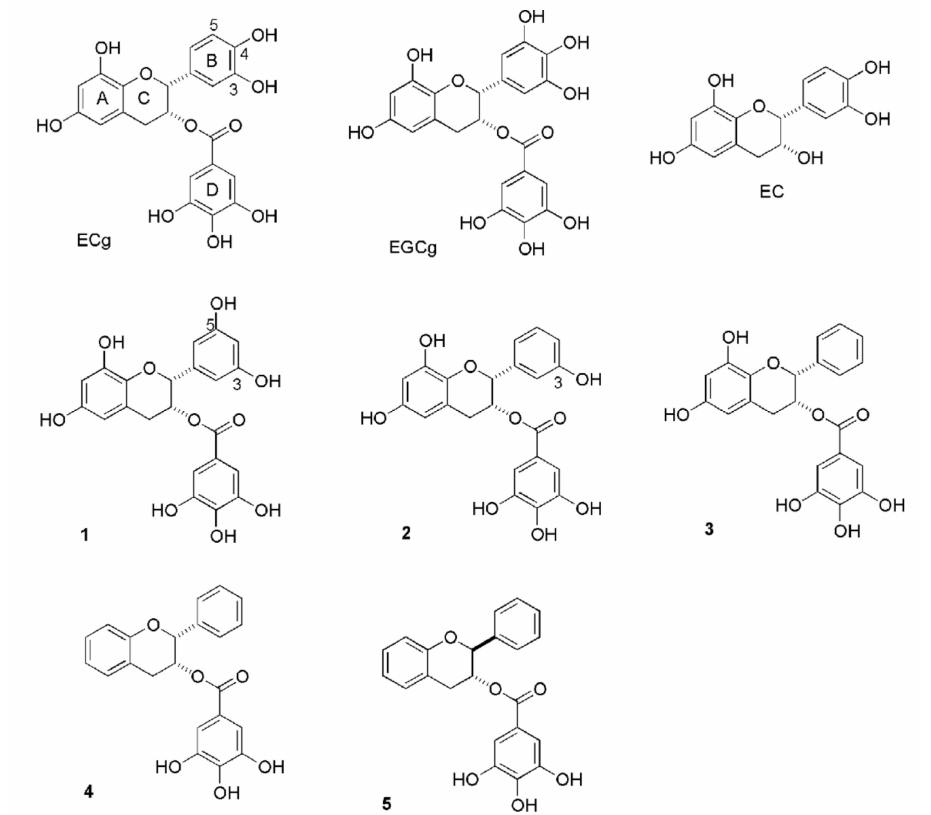
Figure1. Structuresof( − )-epicatechingallate(ECg), ( − )-epigallocatechingallate(EGCg), ( − )-epicatechin (EC), ( − )-3,5-dihydroxy B-ring modified ( − )-ECg (1), ( − )-3-hydroxy B-ring modified ( − )-ECg (2), ( − ) B-ring modified ( − )-ECg (3), ( − )-A,B-ring modified ( − )-ECg (4) and A,B-ring modified ( − )-Cg (5). Reproduced from Palacios et al. [81] under the terms of the Creative Commons Attribution